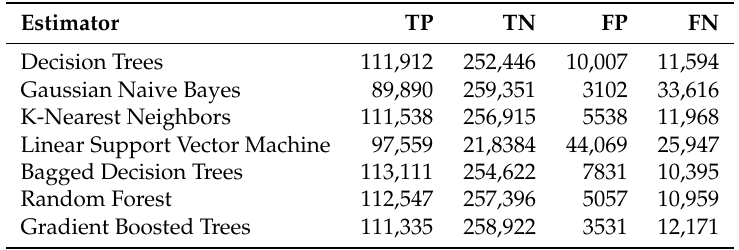
Table 2. Components of the confusion matrices for synthetic data.